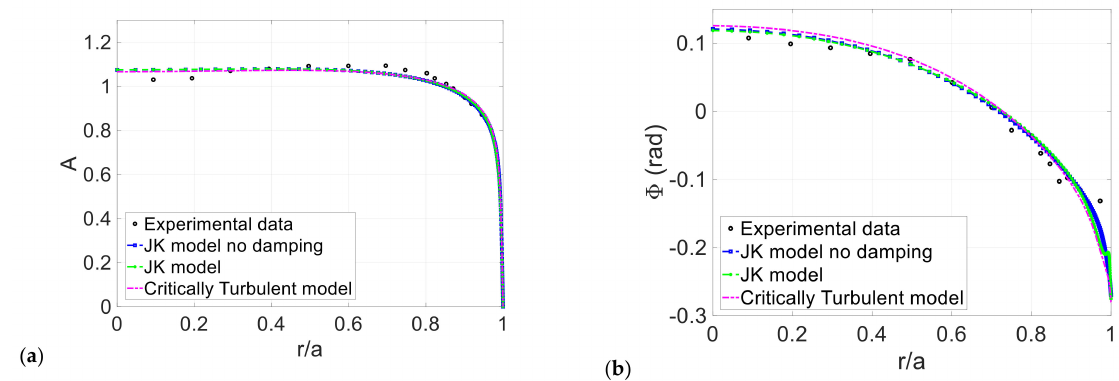
Figure 11. Comparison between experimental data, turbulence models and the critically turbulent assumption (Case 5: Re os = 64,500, α = 40.5): ( a ) amplitude ratio; ( b ) phase-shift.